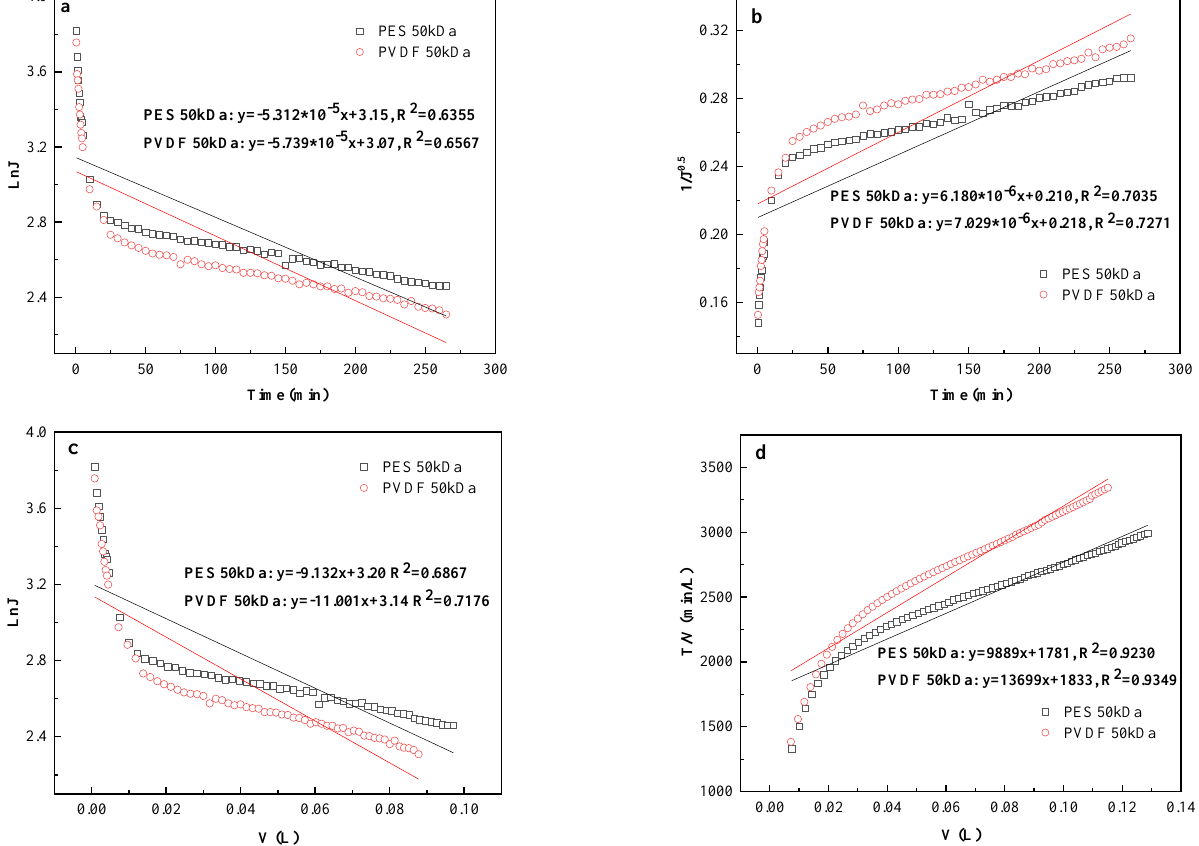
Figure 9. Pore blocking models fitting of tanning wastewater ultrafiltration: ( a ) complete blocking; ( b ) standard blocking; ( c ) intermediate blocking; ( d ) cake filtration (operating condition: 1.0 bar, 2.9 × 10 3 s −1 , 20 °C).